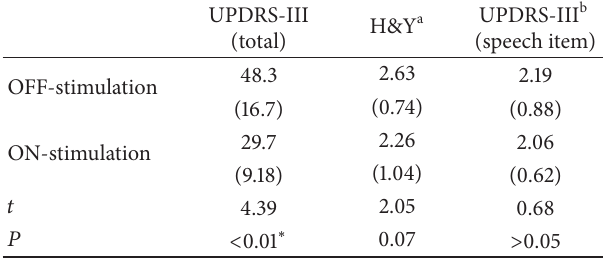
Significant effect. a H&Y = Hoehn and Yahr. b